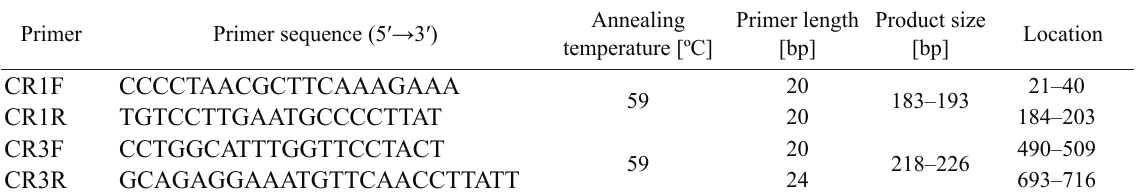
Location = location in the Y14724 sequence submitted to